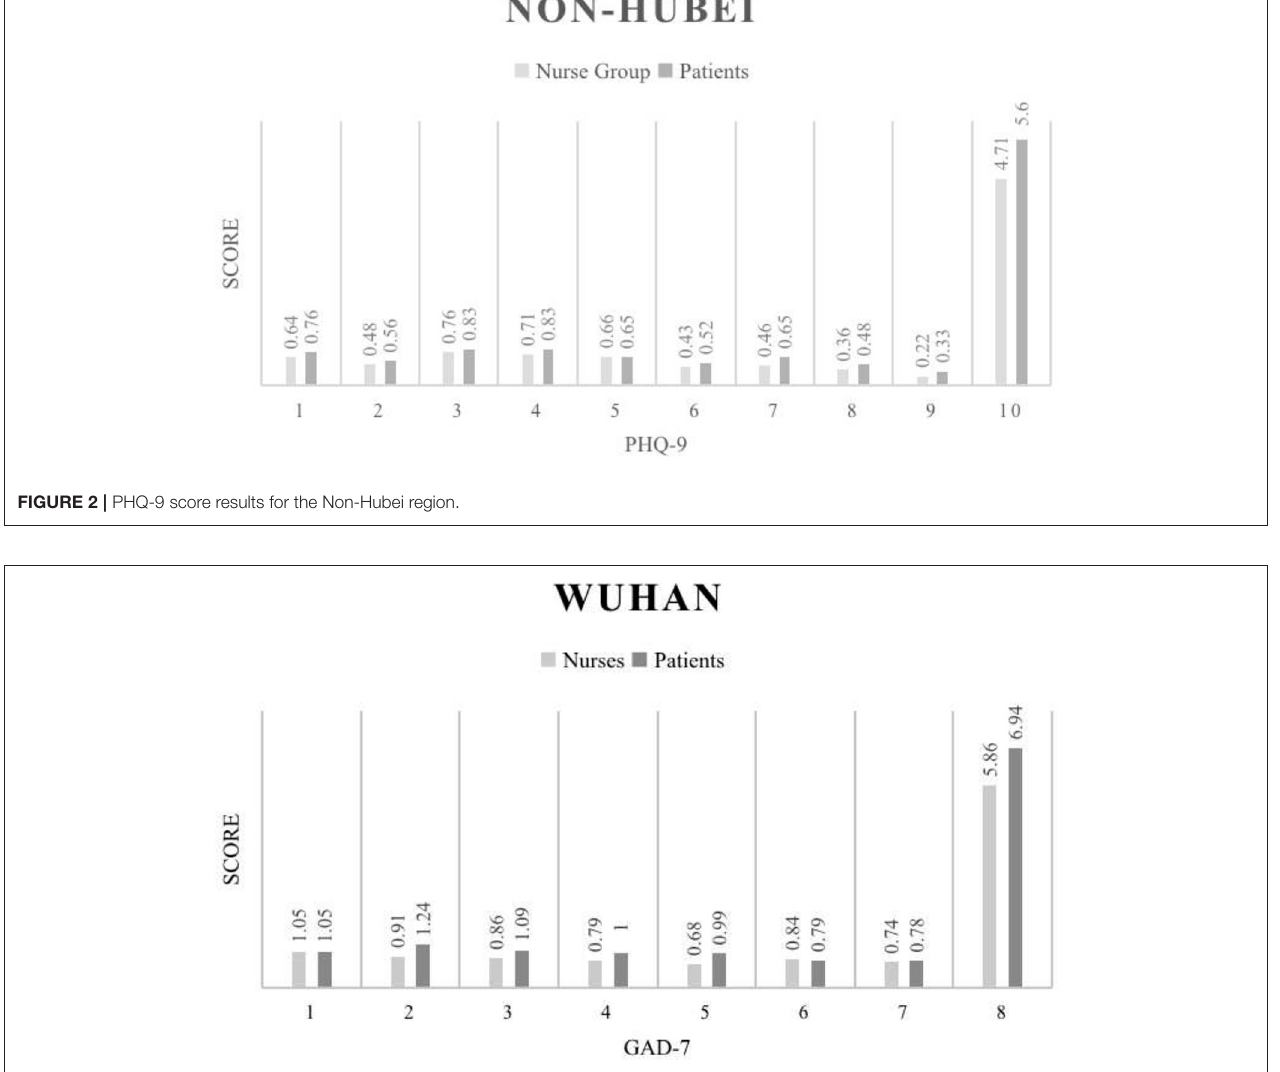
FIGURE 3 | GAD-9 score results for the Wuhan